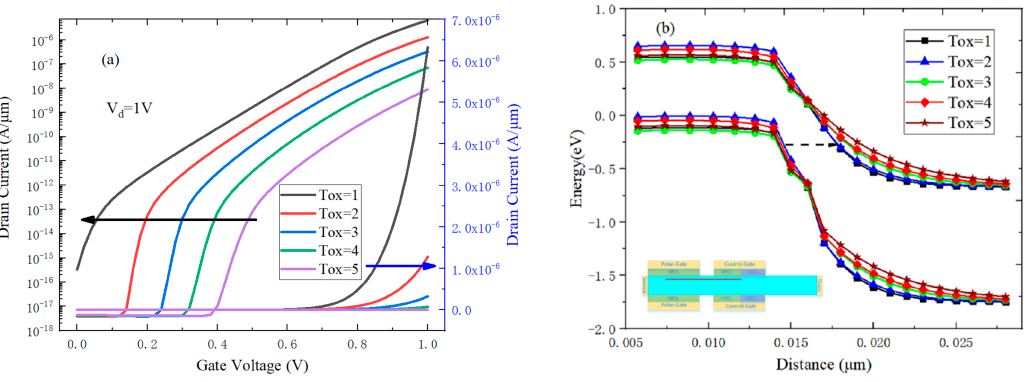
Figure 6. Effect of the gate oxide dielectric thickness on the device performance. ( a ) Transfer characteristics; and ( b ) energy band of the tunnel junction under the on state.